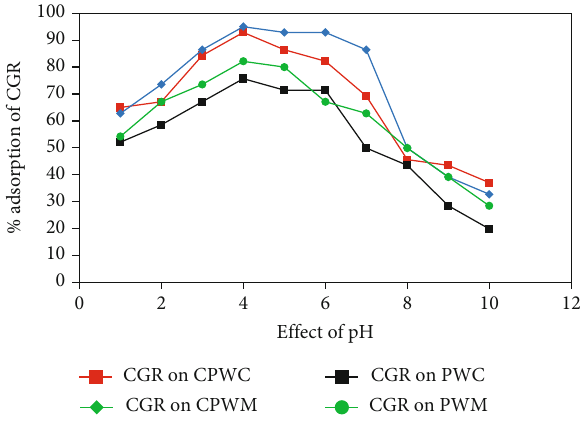
Figure 12: The impact of initial pH on adsorption performance.